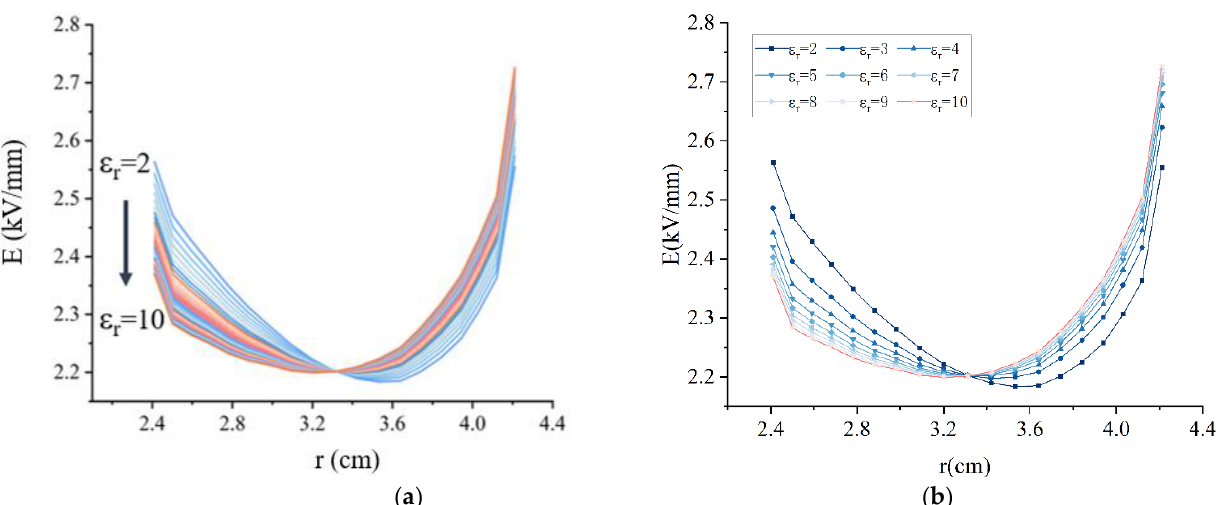
Figure 13. Electric field intensity distribution of the capacitor packet. ( a ) Parametric scanning results; ( b ) Comparison of electric field intensity at different position.